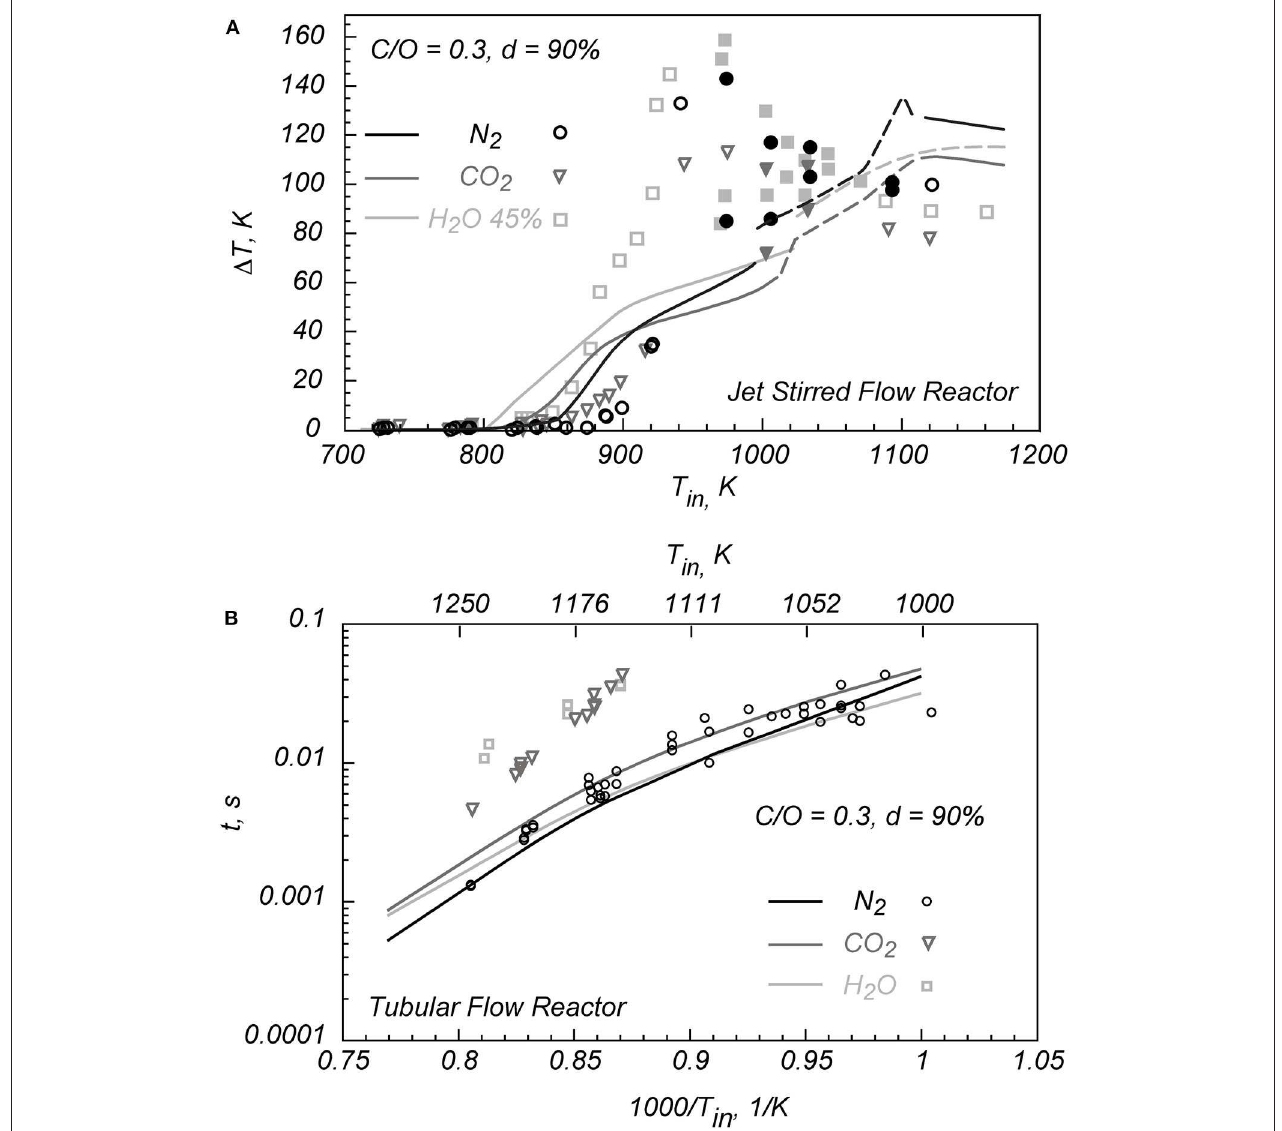
FIGURE 2 | Effects of H 2 O and CO 2 on the oxidation process of stoichiometric C 3 H 8 /O 2 mixtures in a JSFR (A) , adapted from Lubrano Lavadera et al. (2018a) and Lubrano Lavadera et al. (2016), and the autoignition delay times of stoichiometric C 3 H 8 /O 2 mixtures in a TFR (B) , adapted from Sabia et al.